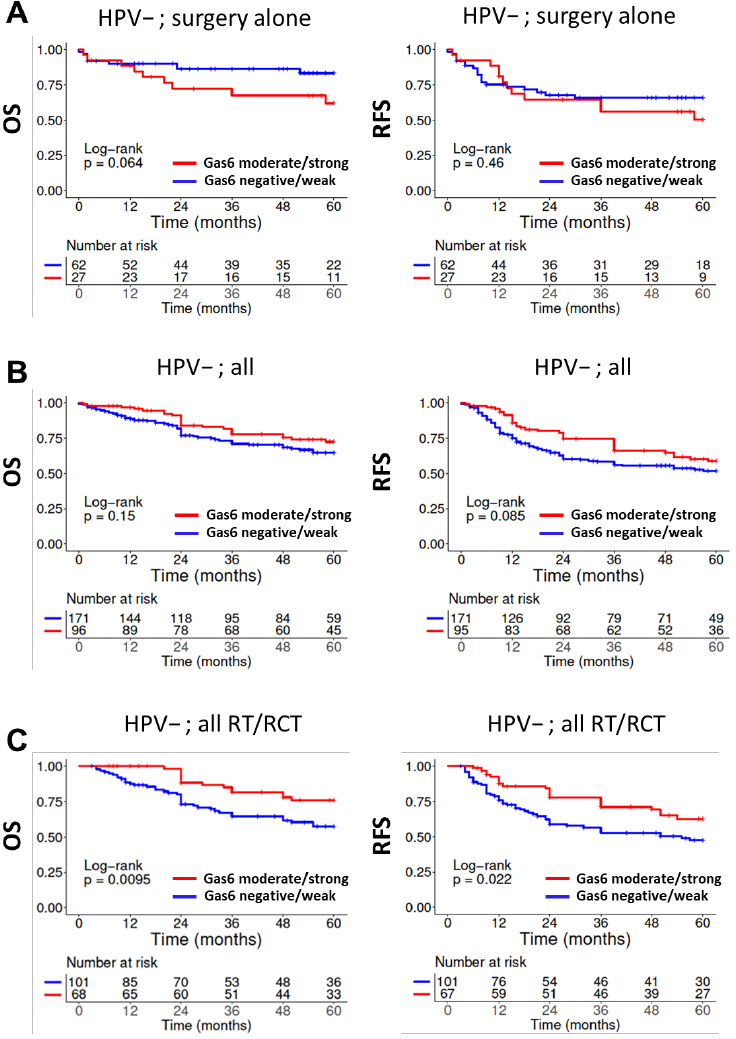
Figure 4. Association of patient survival and Gas6 expression in patients with HPV-negative tumors. Patients were separated into a lower (negative/weak) and higher (moderate/strong) expression group. ( A ) OS and RFS of patients treated by surgery alone. ( B ) OS and RFS of patients irrespective of treatment. ( C ) OS and RFS of patients treated by RT in any form.